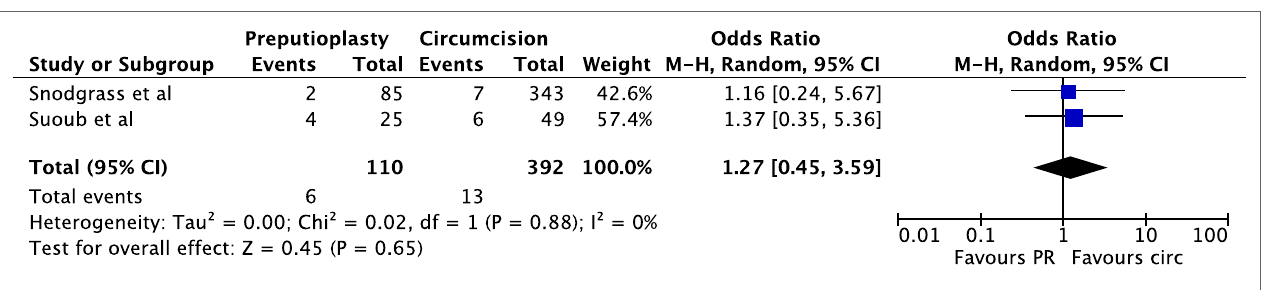
FigUre 4 | Forest plot comparing preputioplasty vs. circumcision for the outcome reoperation .